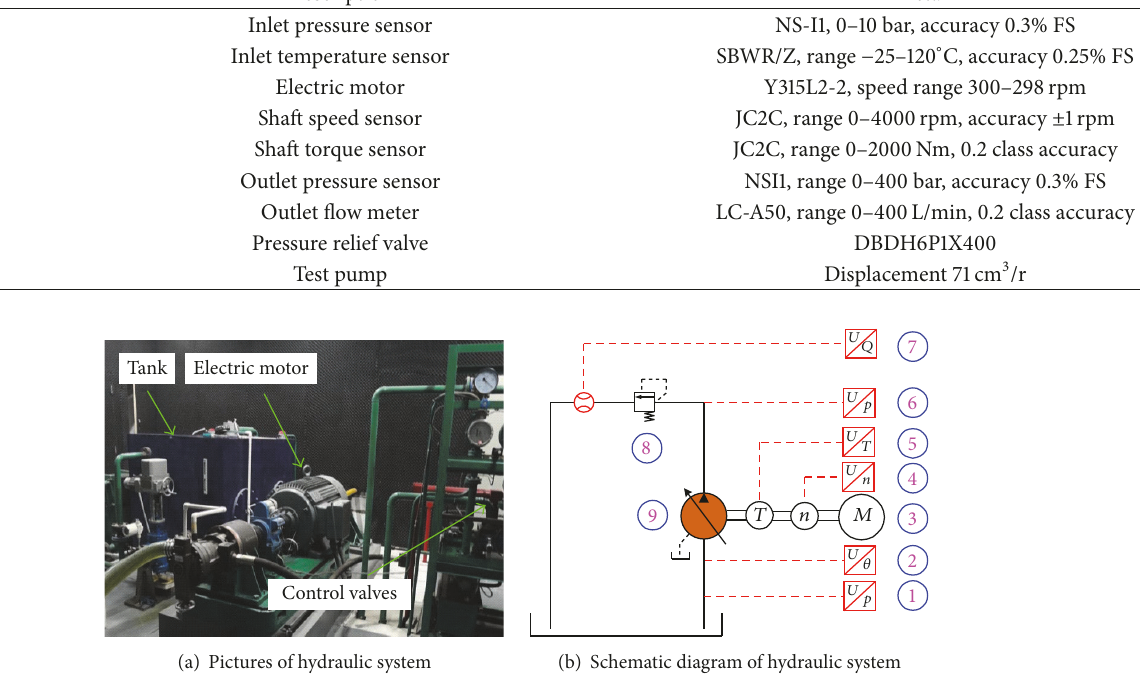
(b) Schematic diagram of hydraulic system Figure 10: Hydraulic system used to drive the pump.